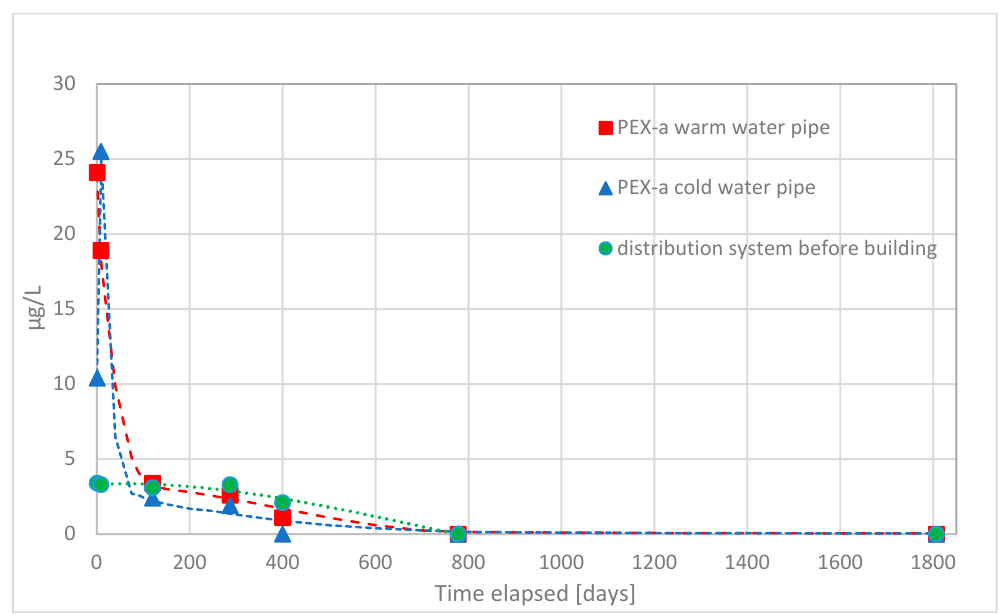
Figure 3. The observed concentrations of migrated methyl tert-butyl ether (MTBE) during the first five years of use of the office building, from the PEX-a water pipes into the drinking water in their corresponding concentration in the water entering the building from the waterworks distribution system.